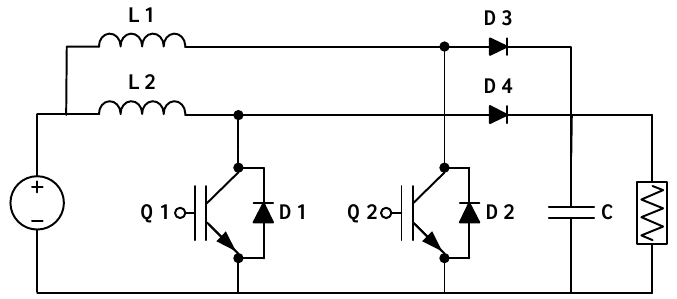
Figure 3. Circuit diagram of the interleaved boost converter.